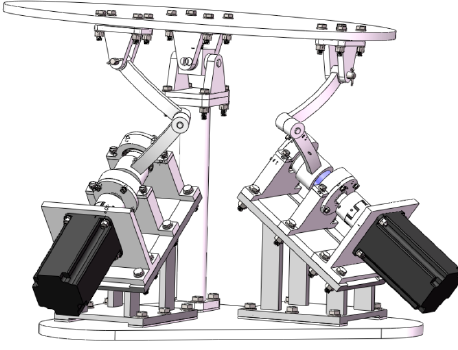
Figure 3. Virtual Figure 3. Virtual prototype.